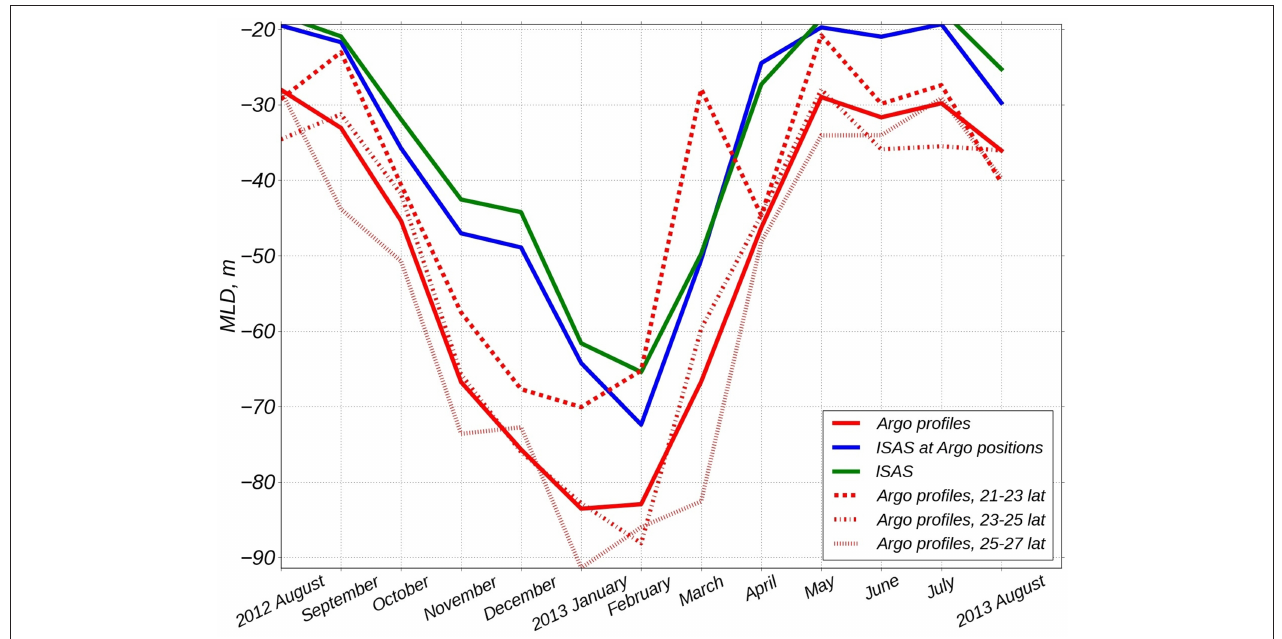
FIGURE 4 | MLD from Argo (red) and ISAS interpolated product (blue and green) for period August 2012—August 2013. MLD from Argo profiles for different latitude bands (red dashed lines).